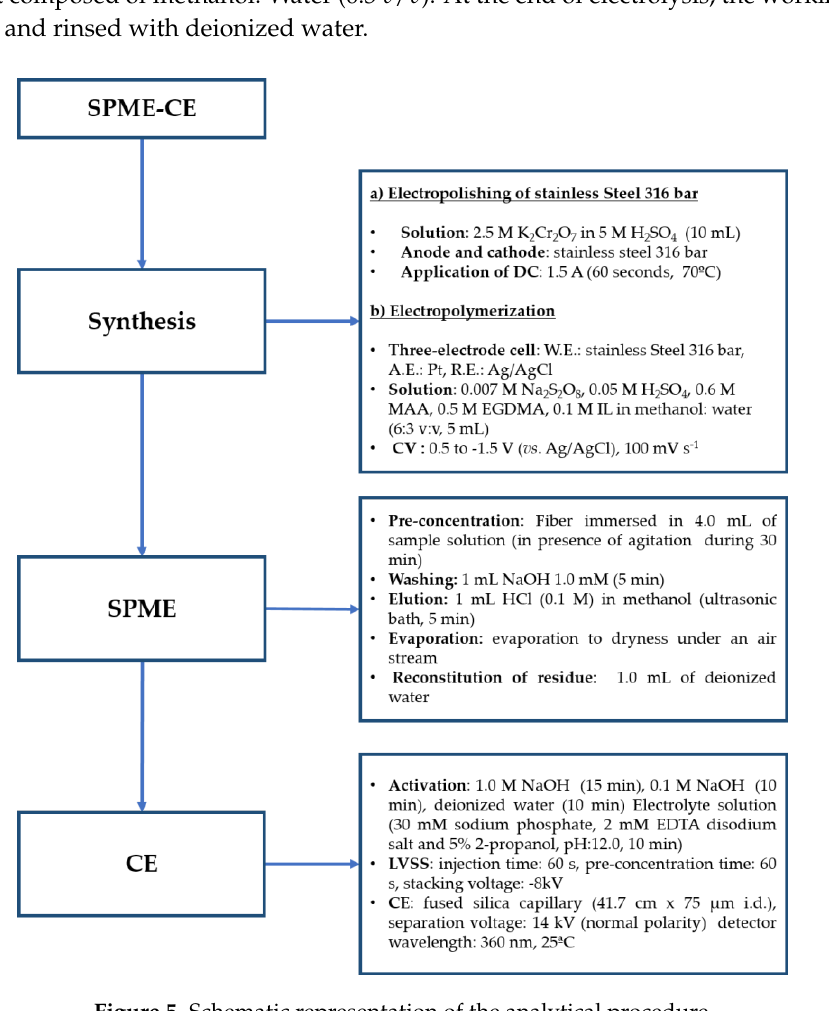
Figure 5. Schematic representation of the analytical procedure.